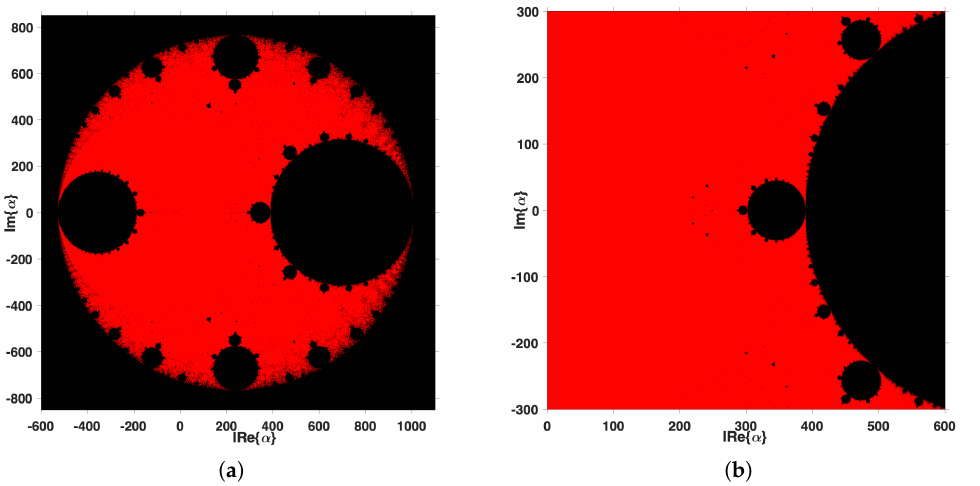
Figure 3. Parameter planes p β q for free critical points. ( a ) Parameter plane with z “ cr 1 p β q . ( b ) Zoomed-in view of the parameter